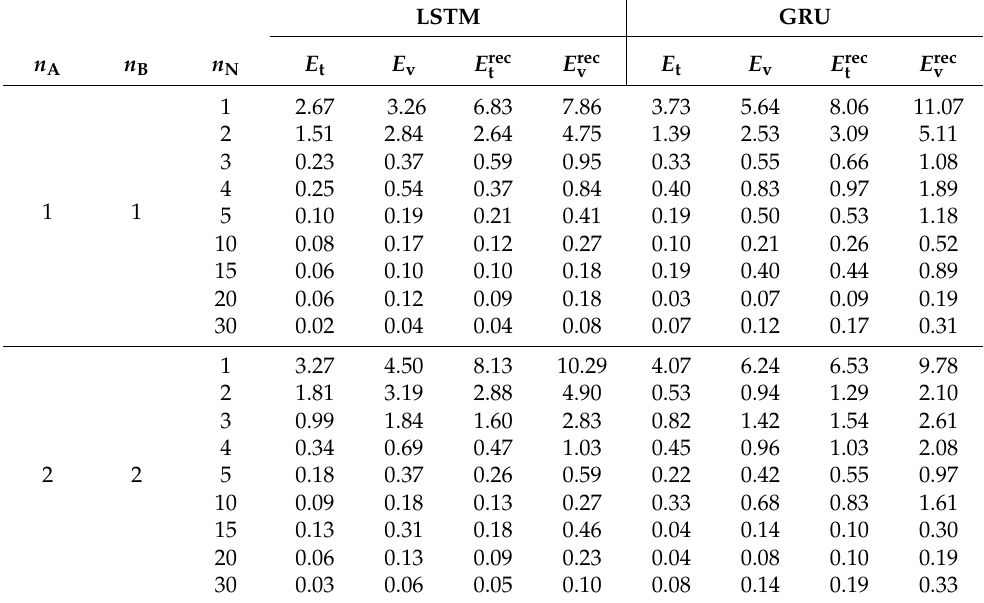
Table 2. The polymerisation reactor: comparison of selected LSTM and GRU networks with the recurrent inputs in terms of the training ( E t ) and validation errors ( E v